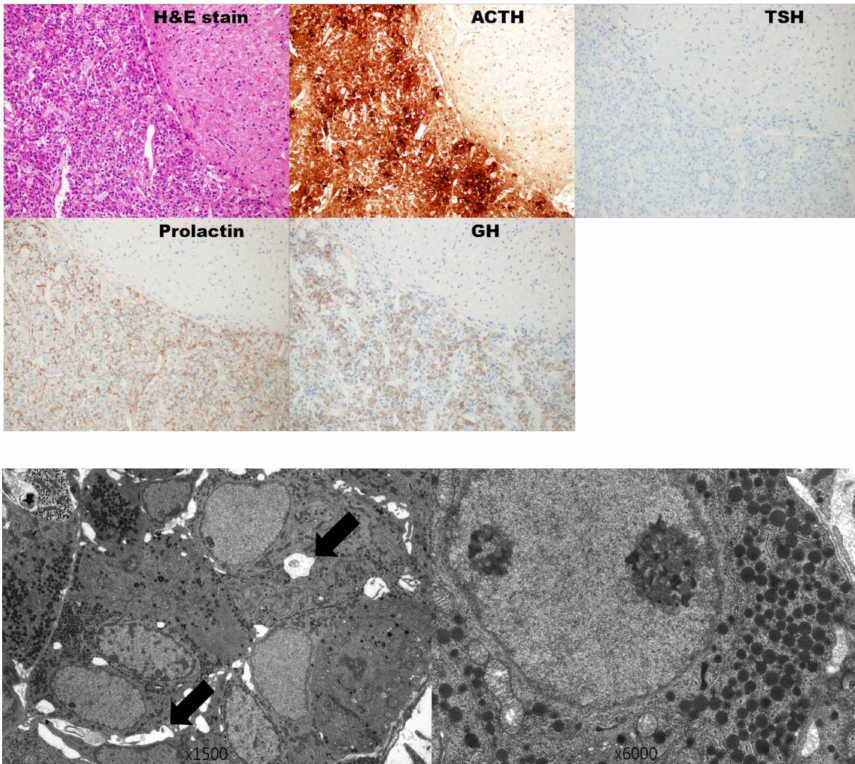
Figure 7. H&E stain showing well-preserved adeno- and neuro-hypophysis at 3 days after transplantation. Special immunohistochemical study showing strong positive staining for ACTH, prolactin, and GH. However, TSH showing relatively weak staining on ImmunoHistoChemistry IHC examination. (Original magnification × 200). EM examination of the harvested pituitary gland from the omental pouch at 3 days after transplantation. EM examination showed nearly normal ultrastructure except small necrotic areas (black arrow). (original magnification × 1500) Structures of mitochondria, RER, and nucleus were maintained similar to those of the normal gland. The number and structure of SGs were also retained. (original magnification ×